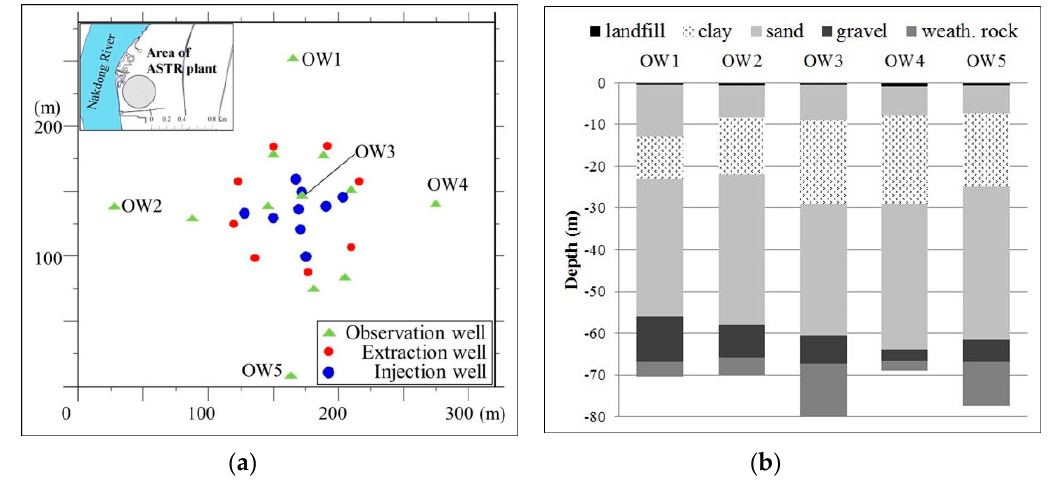
Figure 3. Wells ( a ) and boring log ( b ) at Samrak Park ASTR site.